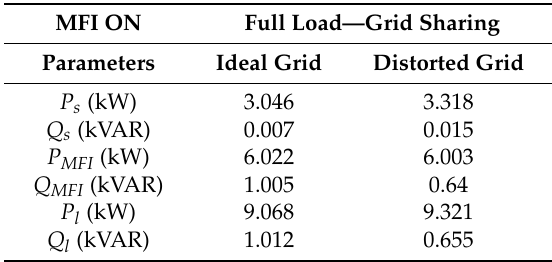
Table 4. Active and reactive power summary of the source, MFI, and load under grid sharing